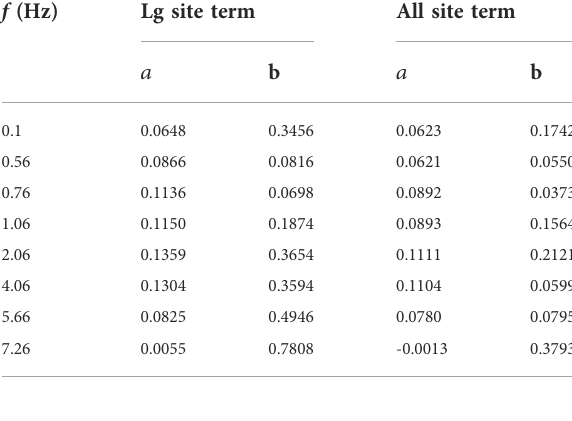
TABLE 2 Linear regression coef fi cients of natural logarithms of Lg site terms and all three sets of site terms as a function of sediment thickness in km at each center frequency ( f